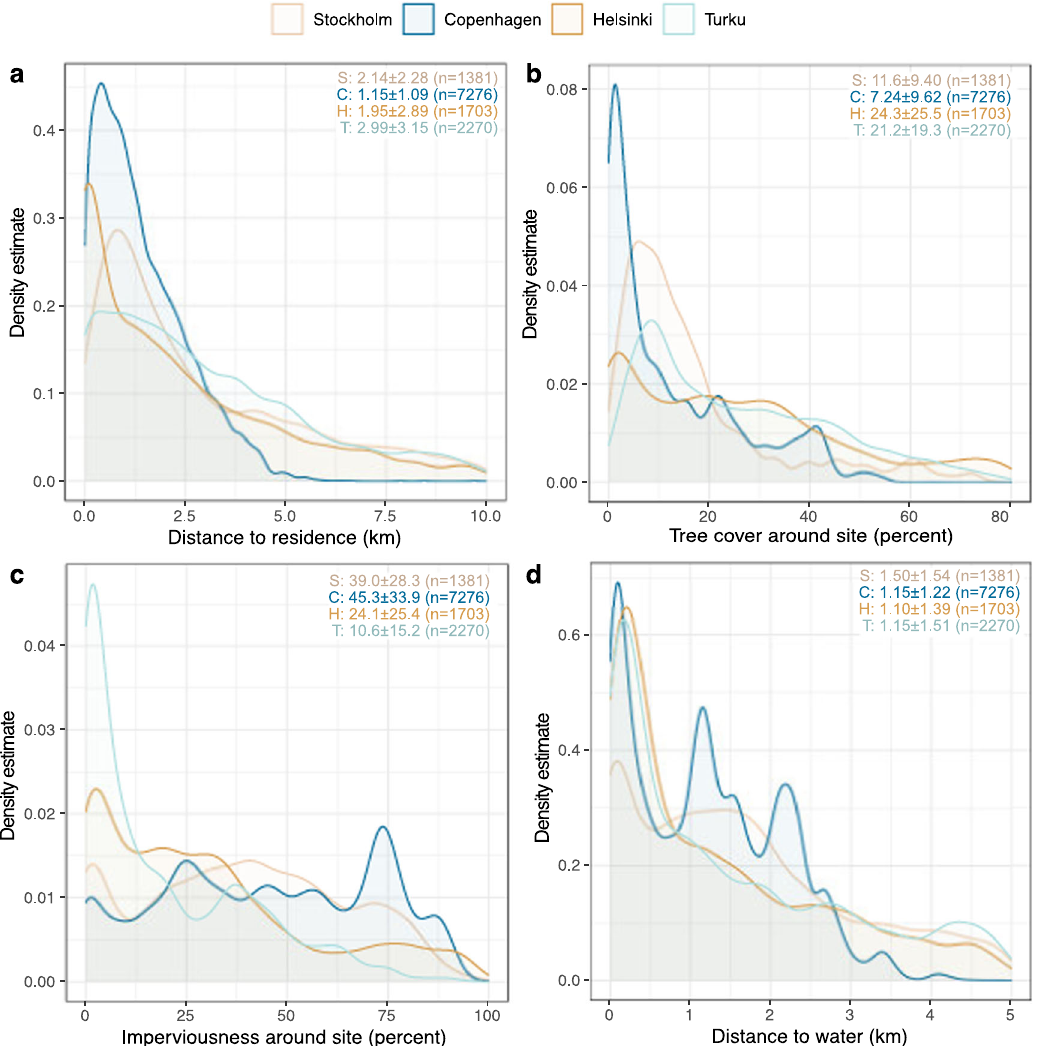
Fig. 1 Comparison of outdoor recreation sites across the four case cities. City-wise kernel density estimates ( y -axes) for a set of recreation site characteristics ( x -axes): a distance to residence, b tree cover density, c imperviousness density, and d distance to water. In the upper right corner, each city ’ s median ± median absolute deviation (MAD) and number of outdoor recreation sites is